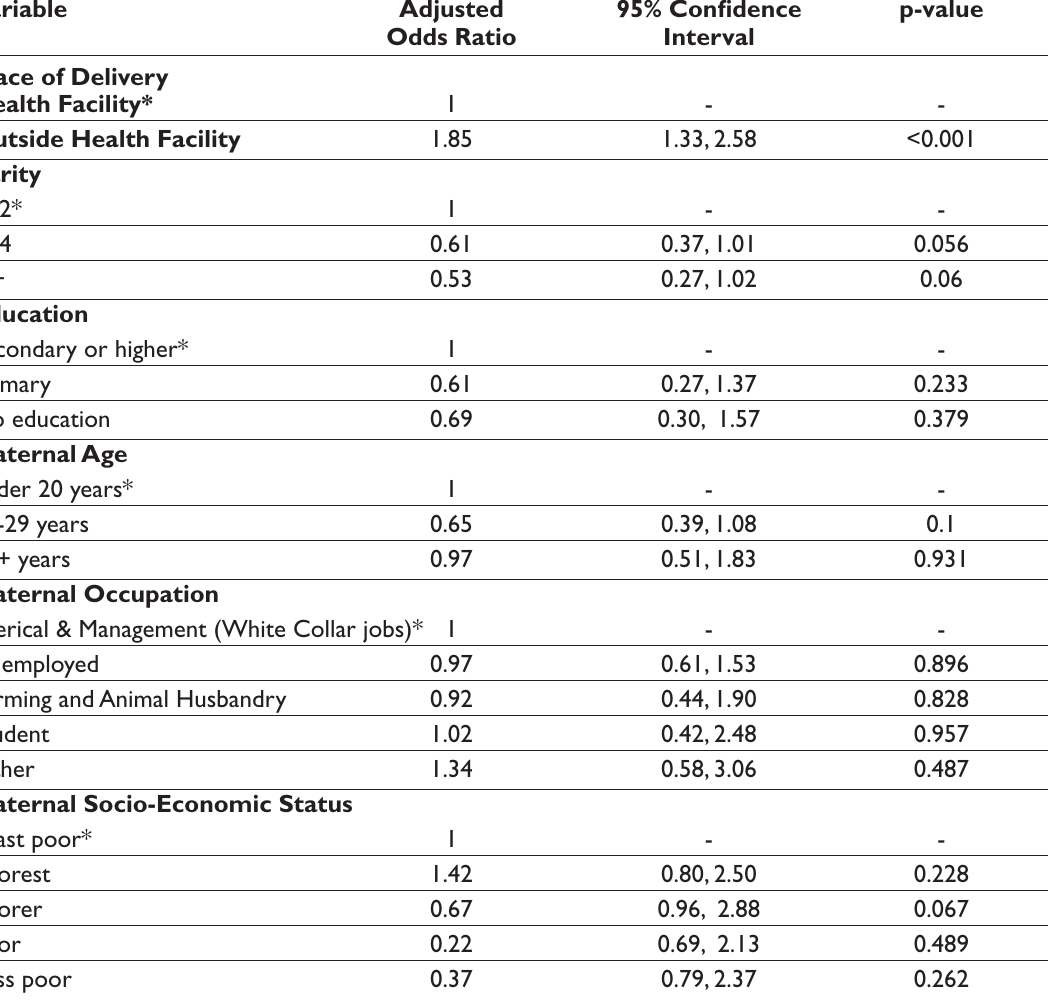
Table 4. Adjusted Odds ratio (OR) Estimates and 95% Confidence Intervals for Maternal Risk Factors Associated with Neonatal Mortality (Multivariate Logistic Regression